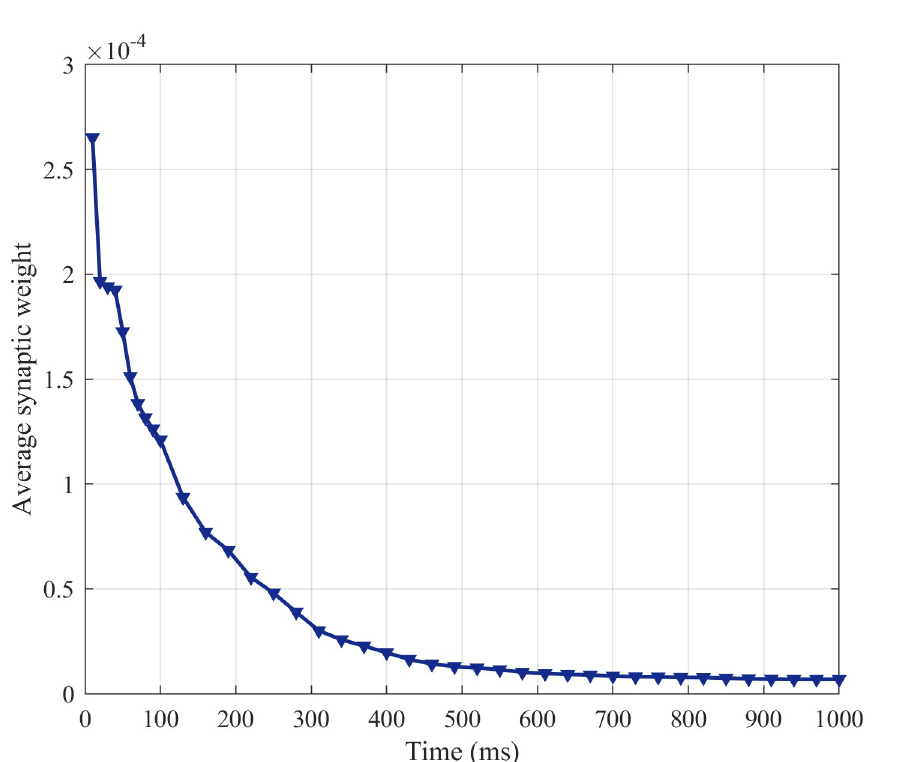
Fig 15. The change in the average synaptic weight with time.